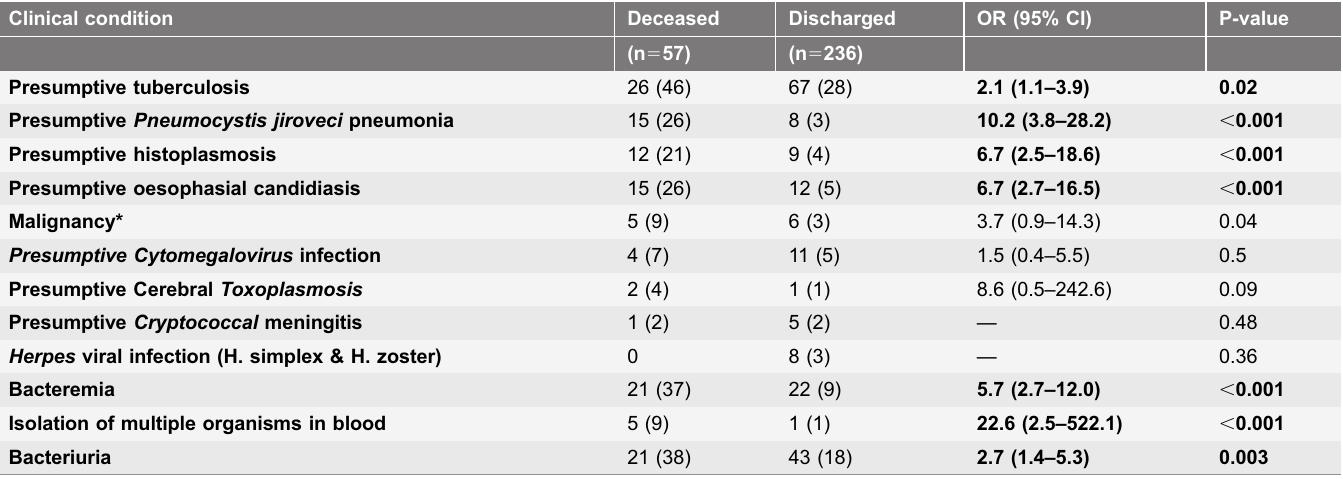
Table 2. Diagnoses of HIV-infected patients stratified by